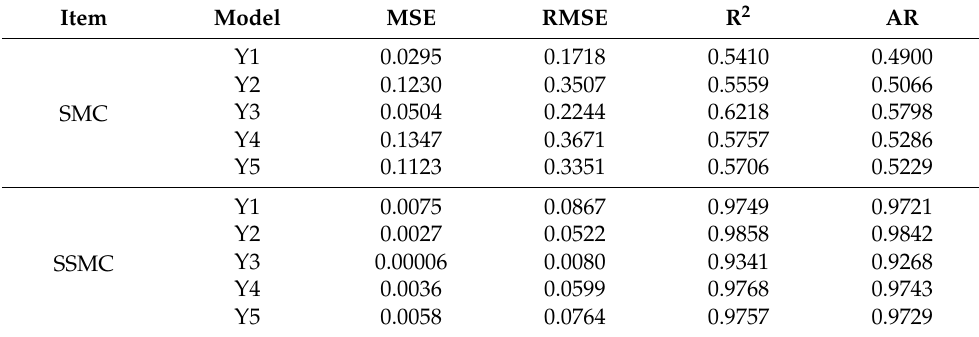
Table 8. Validation evaluation of the soil moisture content construction model.